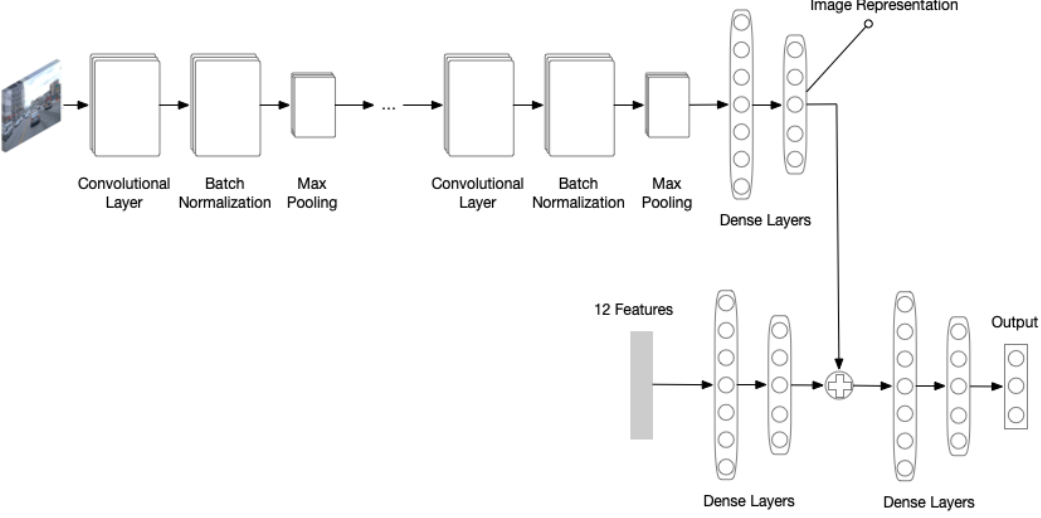
Figure 3. The composited model of NN and CNN. The CNN module uses similar architecture as VGG16. Each layer consists of three sub-layers: one standard CNN layer with kernel size 5, one batch normalization layer with batch size 32 and one max pooling layer. The last two layers are dense layers with 100 hidden units and 50 hidden units, respectively. Notice that the output of the last dense is the trained representation of the input image. The NN module is a simple two-layer neural network with 100 hidden units and 50 hidden units. The outputs of the NN module and CNN module are concatenated to form new dense layers that generate the final acceleration output. The hidden sizes of the last two layers are 100 and